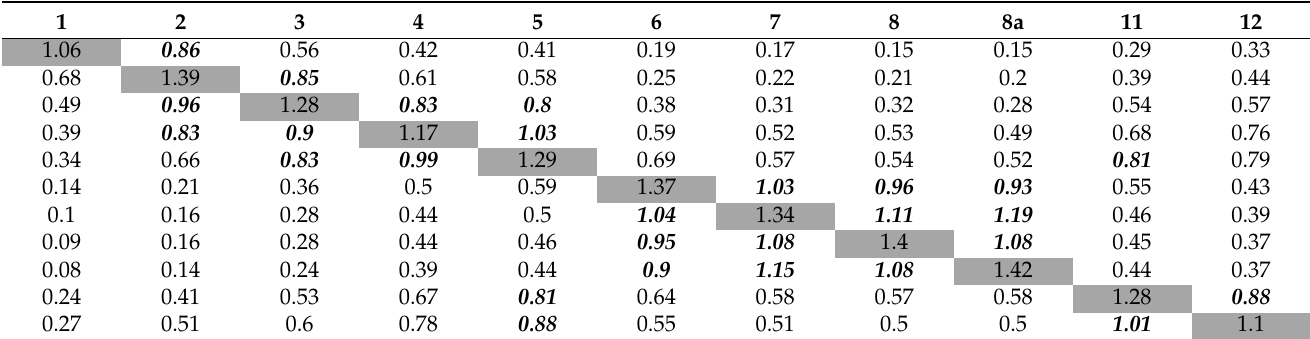
Table 2. Sentinel 2 MSI Band Mutual Information (MI, 3 nearest